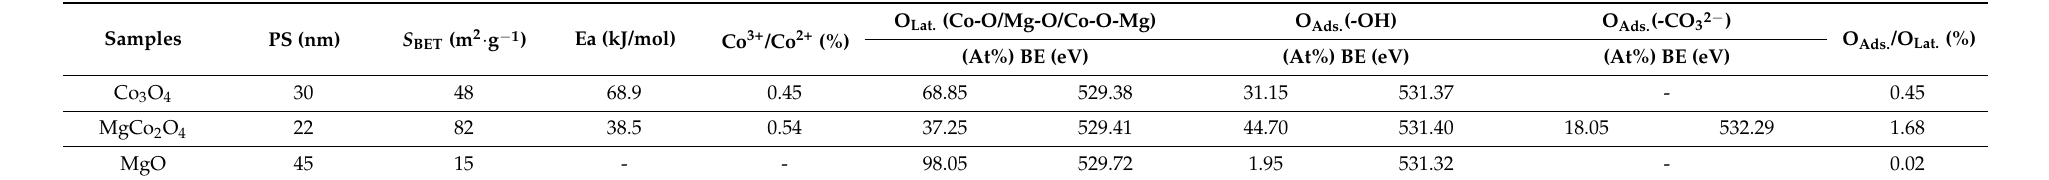
Table 1. Summary of size, specific surface area, activation energy and results of peaks-fittings of O 1s binding energies and relative atomic percentage for Co 3 O 4